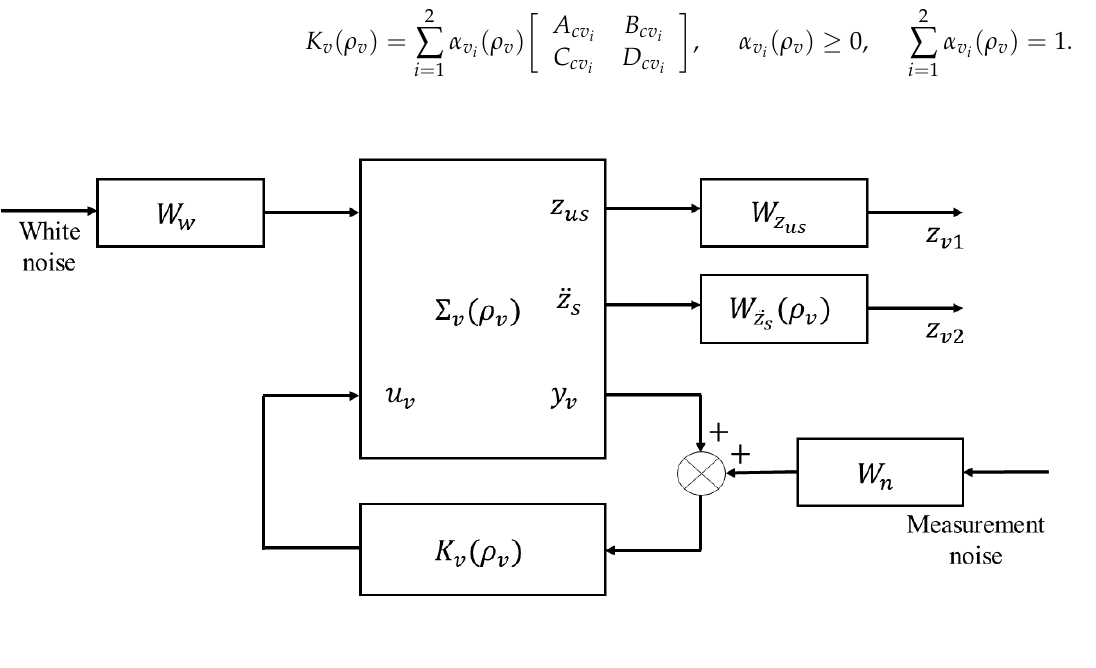
Figure 12. LPV semi-active suspension control generalized system Σ gv ( ρ v )